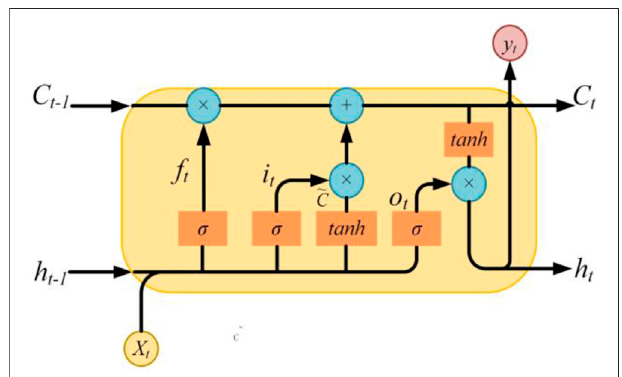
FIGURE 1 | The structure of the LSTM